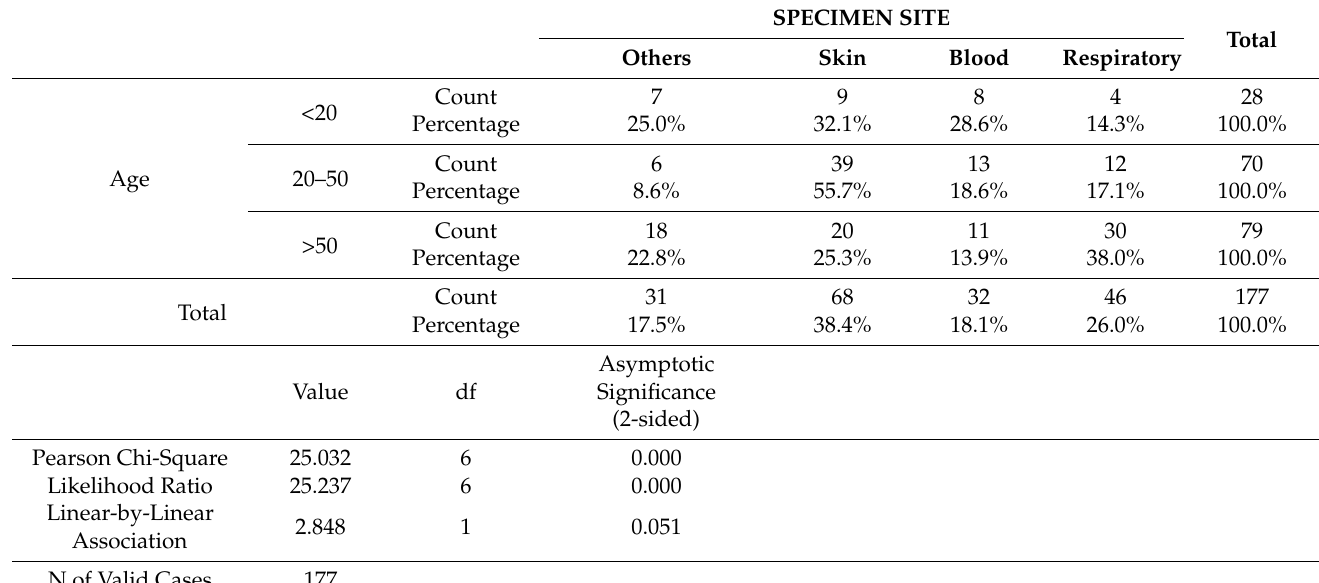
Table 2. Frequency of Staphylococcus aureus isolate from skin and other organs among different age-groups of patients in Ha’il region, Saudi